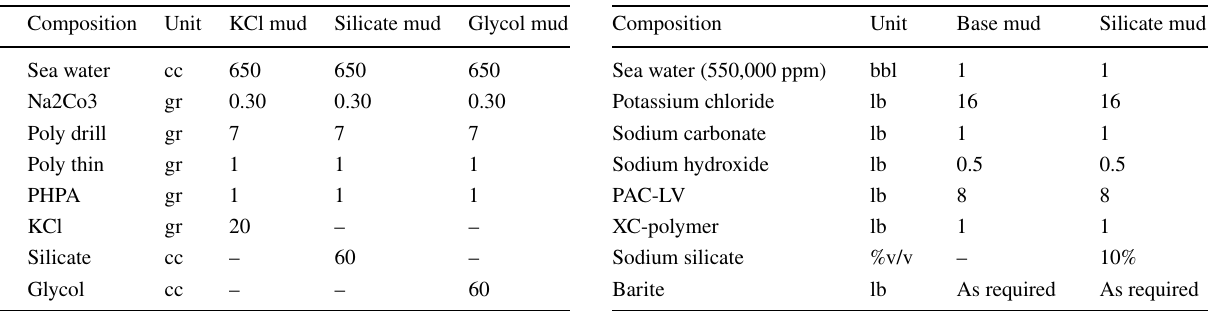
Table 2 Compostion of two different drilling fluid to meaasure